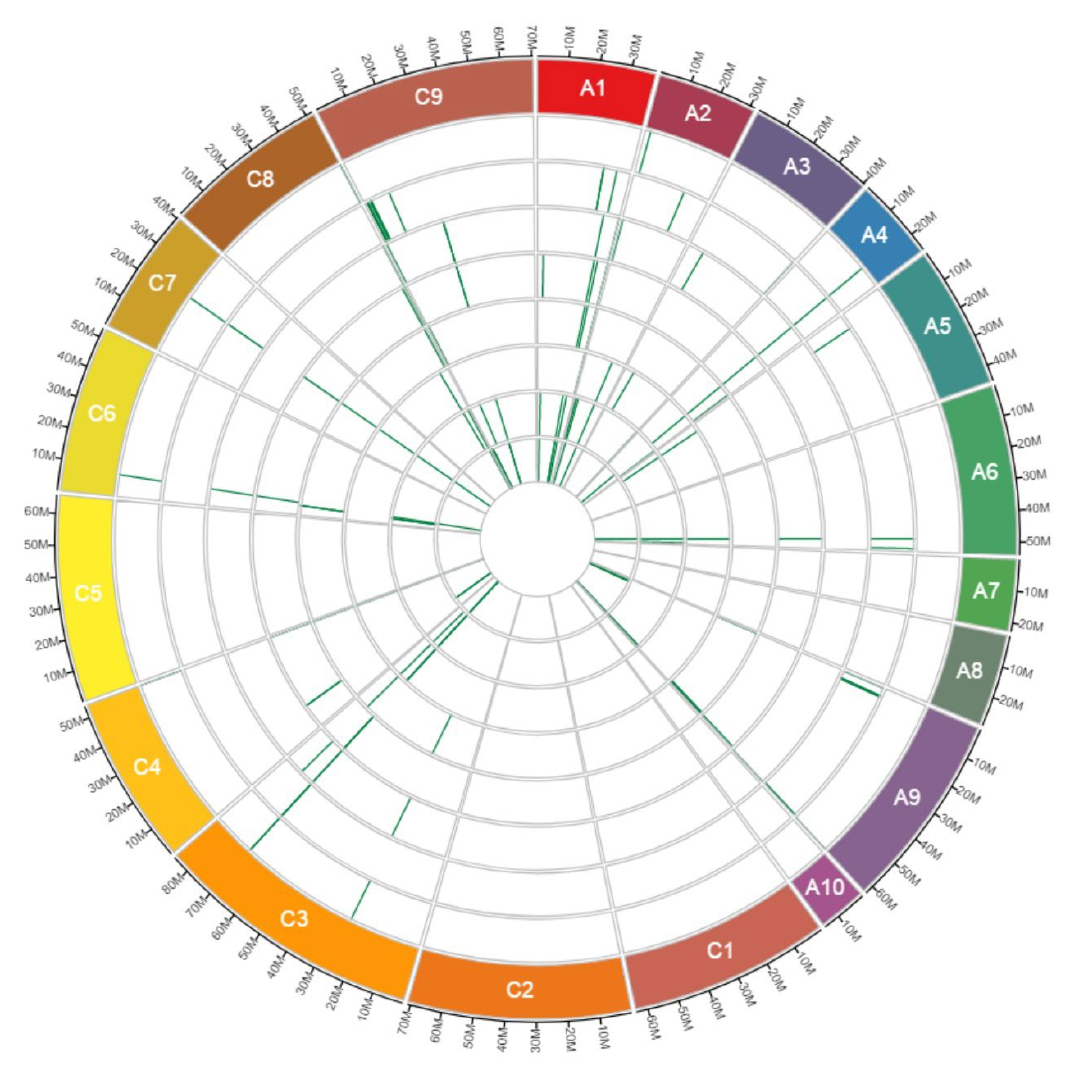
Figure 3. The position of “both deletion and duplication” events in RGAs across the chromosomes of eight winter type and blackleg resistant B. napus cultivars. No “both deletion and duplication” events were detected on chromosomes A07, A08, A10, C01, C02 and C05. The tracks from outer to inner show chromosomes, Ascona, English Giant, Hansen × Gaspard, Milena, Pacific, Pirola, Tina and Wilhelmsburger. Ax and Cx in the coloured boxes are showing chromosomes number.